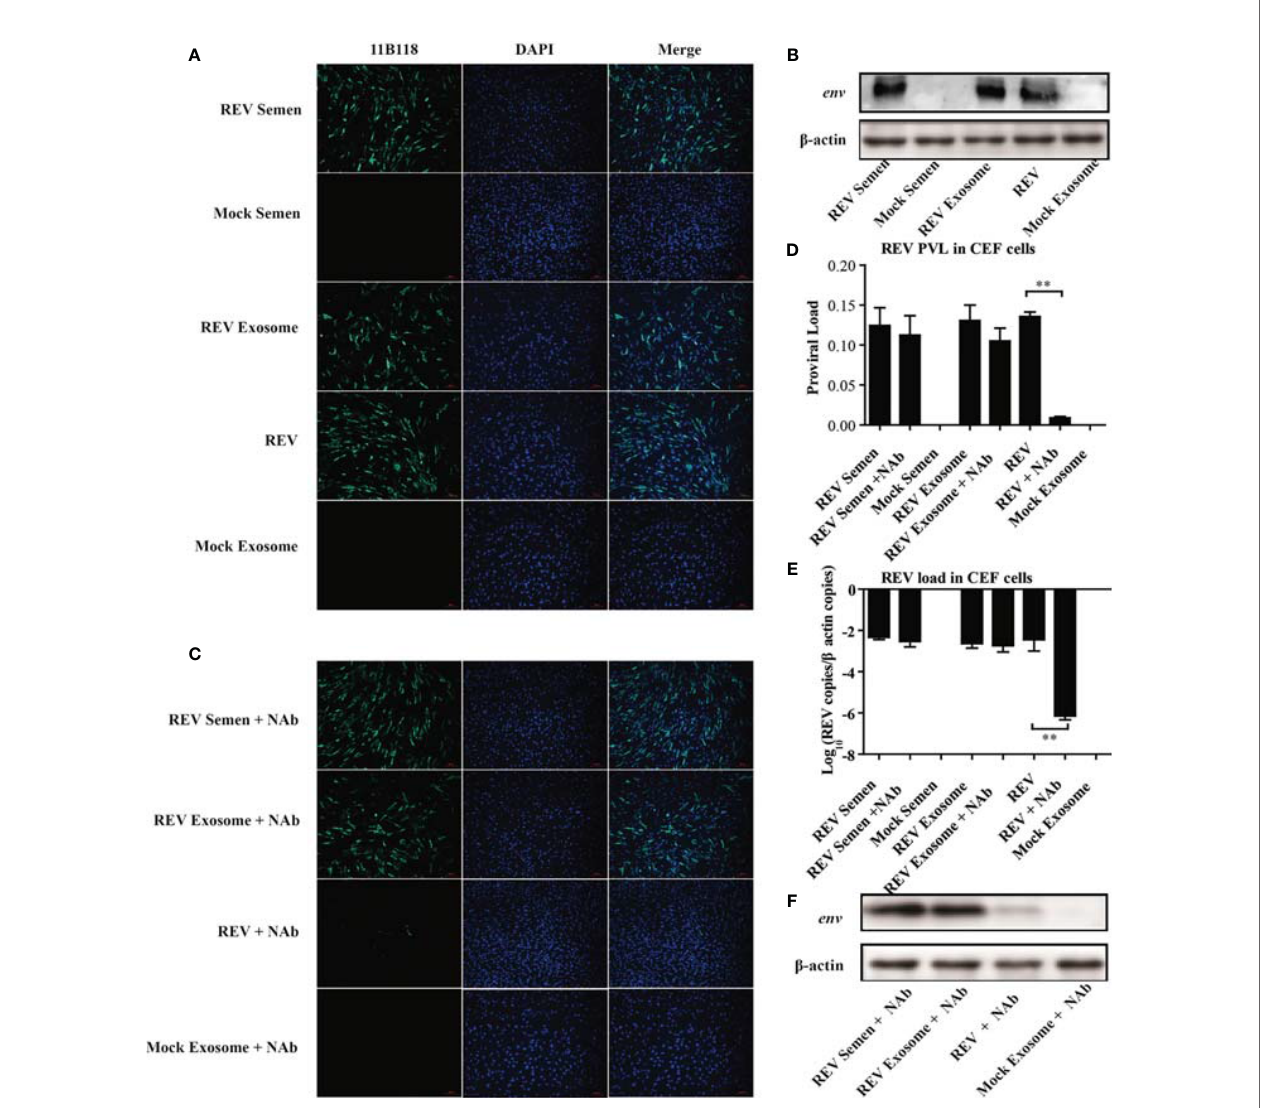
FIGURE 2 | Semen exosomes transmit REV and establish productive infections in chick embryo fi broblast (CEF) cells. (A) Immuno fl uorescence assays (IFAs) demonstrated the productive infection of CEF cells after treatment with REV-positive semen or REV exosomes or infected with REV. At 48 hpi after treatment or infection, the cells were fi xed and an IFA was performed with 11B118. (B) Western blotting analysis of env expression in CEF cells treated with REV semen or REV exosome or infected with REV. (C) REV-positive semen, REV exosome, or free REV was incubated with REV-speci fi c NAbs for 1 h. Then, CEF cells were exposed to the antibody-treated exosomes or virus for 3 h. The semen, exosome, or virus was washed off and the medium was replaced with fresh maintenance medium for a further 48 h for IFAs. Quantitative RT-PCR was performed to detect REV proviral load (D) and viral load (E) in CEF cells. (F) Western blotting analysis of env expression in CEF cells treated with antibody-treated semen, exosome, or virus. **Indicates signi fi cant difference ( p < 0.01) between the two experimental